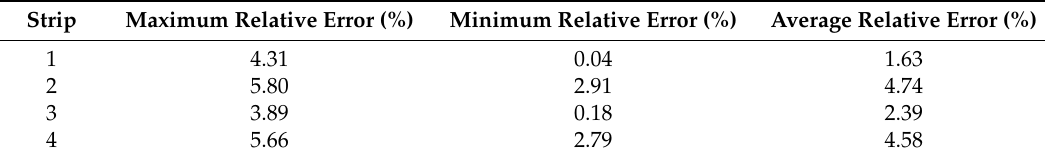
Figure 18. Comparison between actual dry density values and calculated values computed by A-model. Table 4. Relative errors between measured and calculated dry density.